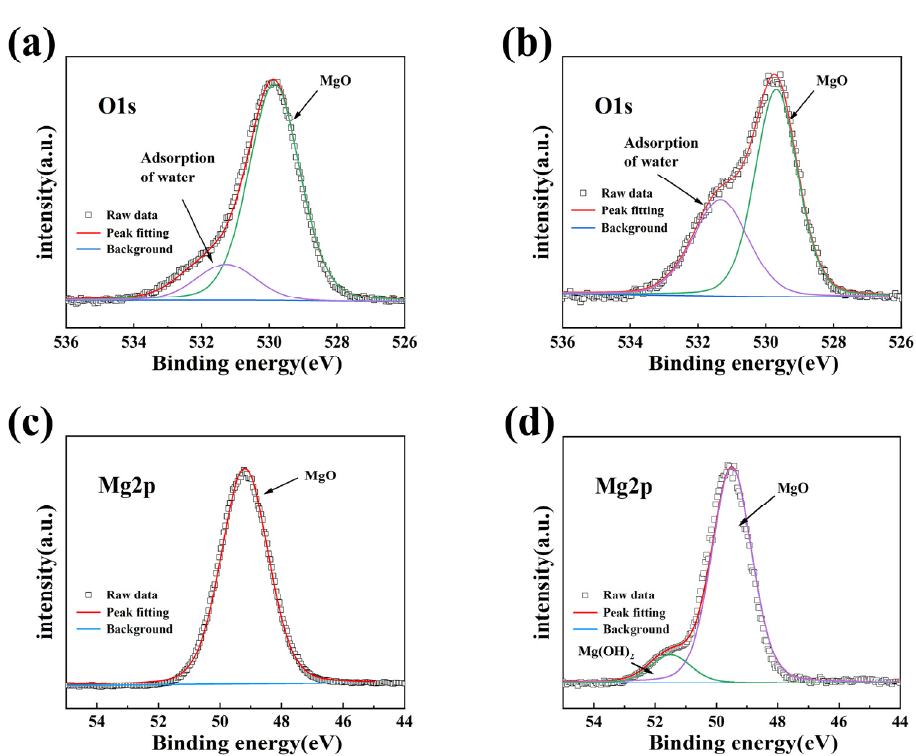
Figure 3. FT-IR spectra of MgO film.